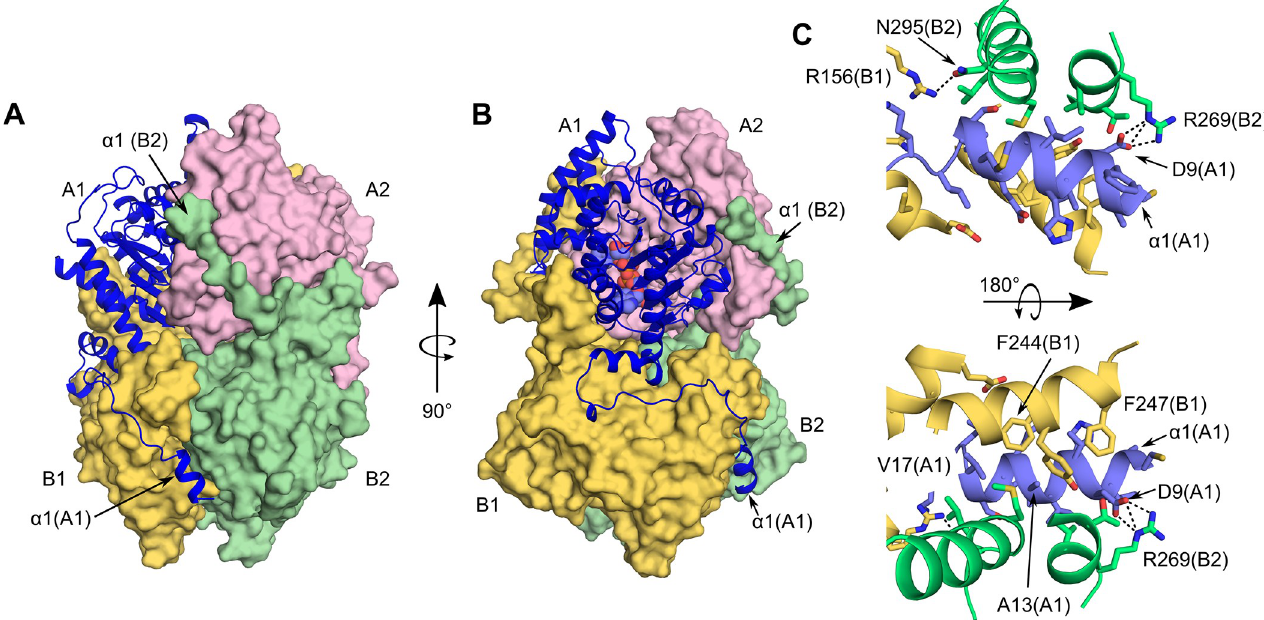
Fig 3. Interprotomer contacts within a BmDHS homotetramer. (A, B) Molecular surfaces for protomers A2, B1, and B2 are shown in the same colors as in Fig 2A. Protomer A1 is depicted as a blue cartoon. The position of the N-terminal α 1 is indicated. (C) Interactions between the N-terminal α 1 from protomer A1 and nearby (4 Å cut-off) residues from protomers B1 and B2. Hydrogen bonds are depicted as dashed black